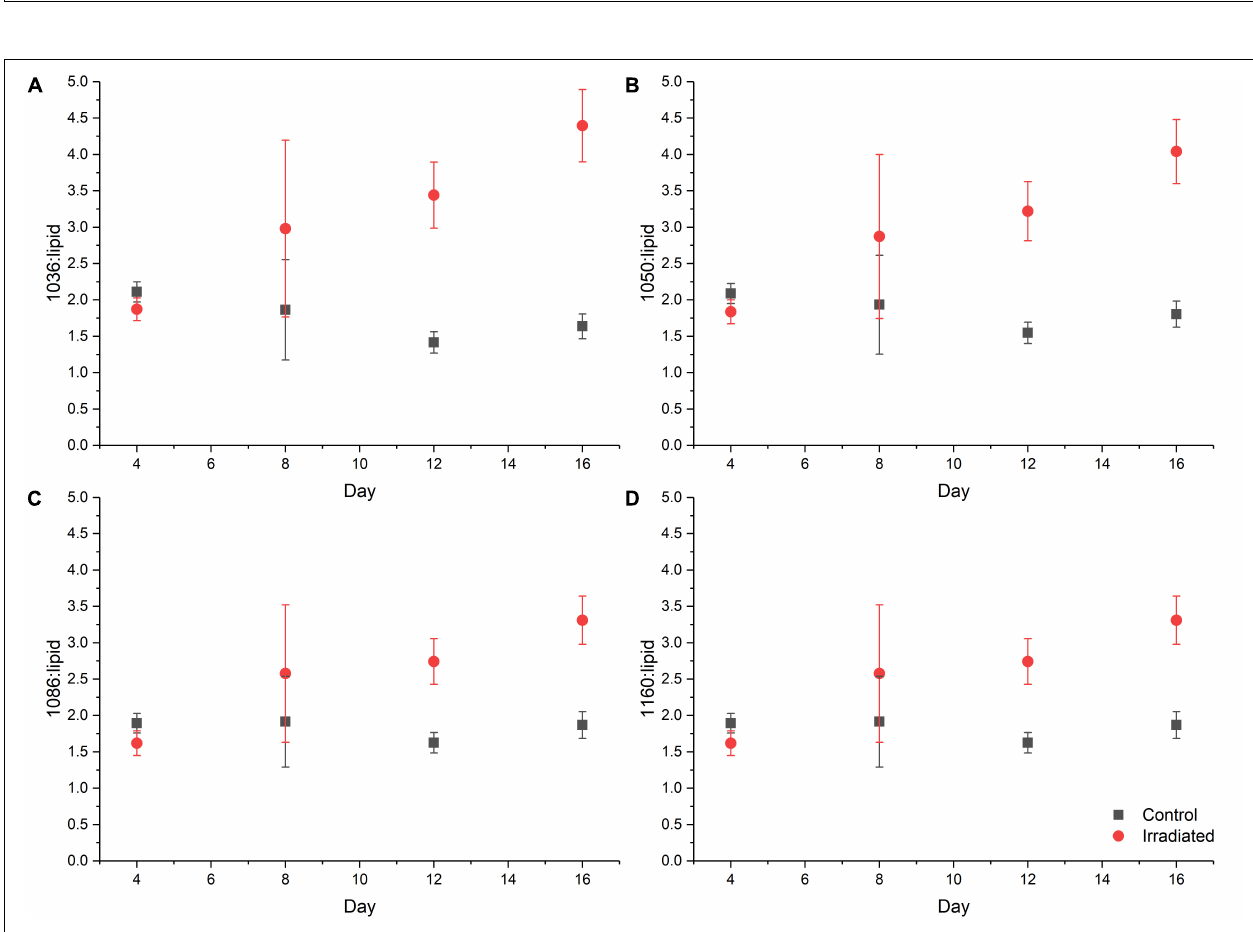
FIGURE 4 | Ratio plot of carbohydrate absorbance peaks: (A) 1036 cm - 1 ; (B) 1050 cm - 1 ; (C) 1086 cm - 1 ; and (D) 1160 cm - 1 normalized to the lipid peak at 1740 cm - 1 taken from FT-IR data, symbols are the means from FT-IR spectra and error bars denote one standard deviation from the mean value.